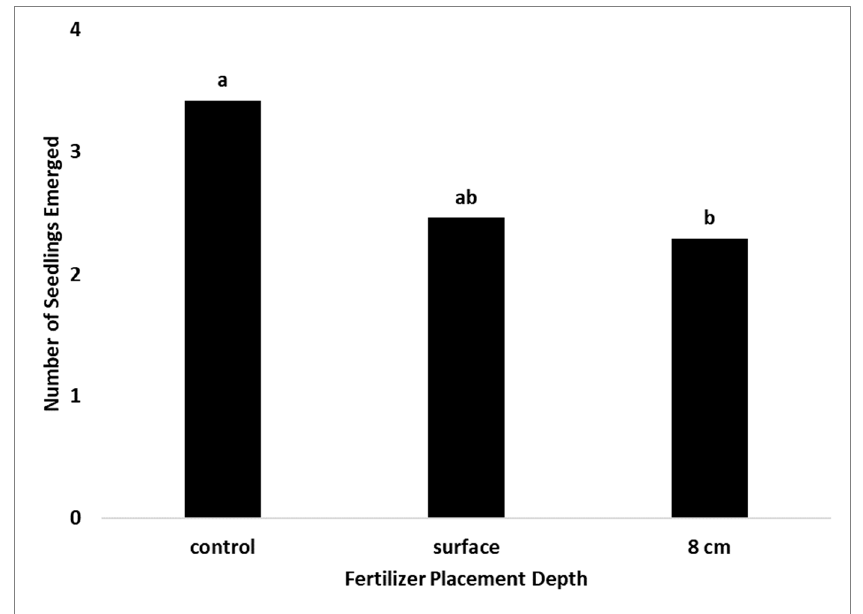
Figure 11. Number of seedlings emerged as a function of fertilizer placement depth compared to an untreated control in a glasshouse study with bottlebrush squirreltail and Siberian wheatgrass. Data were averaged over SAP presence at rates of 0 or 3000 kg ha − 1 and across species. The soil was saturated once and then dried down naturally over the time of the study. The fertilizer was placed at a depth of 8 cm directly below the seed prior to saturation or at the soil surface at the time of planting. Bars with the same letters are not statistically different from each other. p = 0.05.